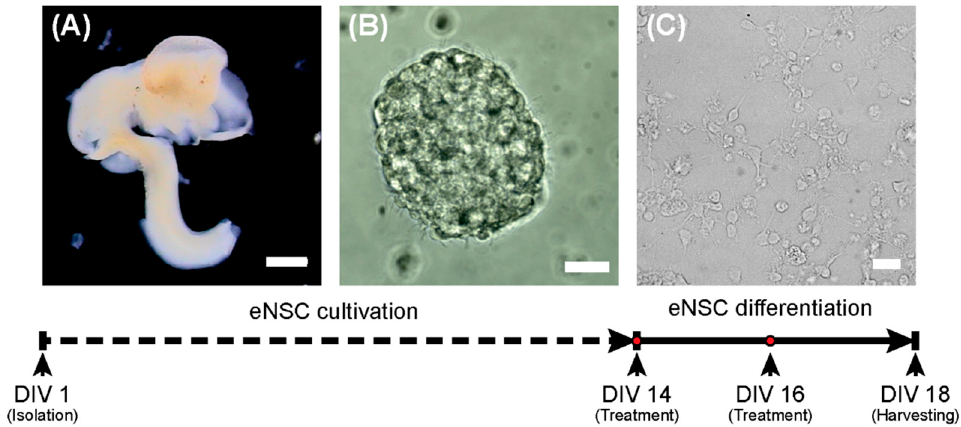
Figure 6. Scheme of the experiment. On the first day (DIV 1), eNSCs were harvested from the E12.5 embryonic central nervous system ( A ) and cultivated as neurospheres ( B ). On day 14 (DIV14), the differentiation process was started ( C ). Scale bars represent 1 mm for (A) and 20 µm (B,C).